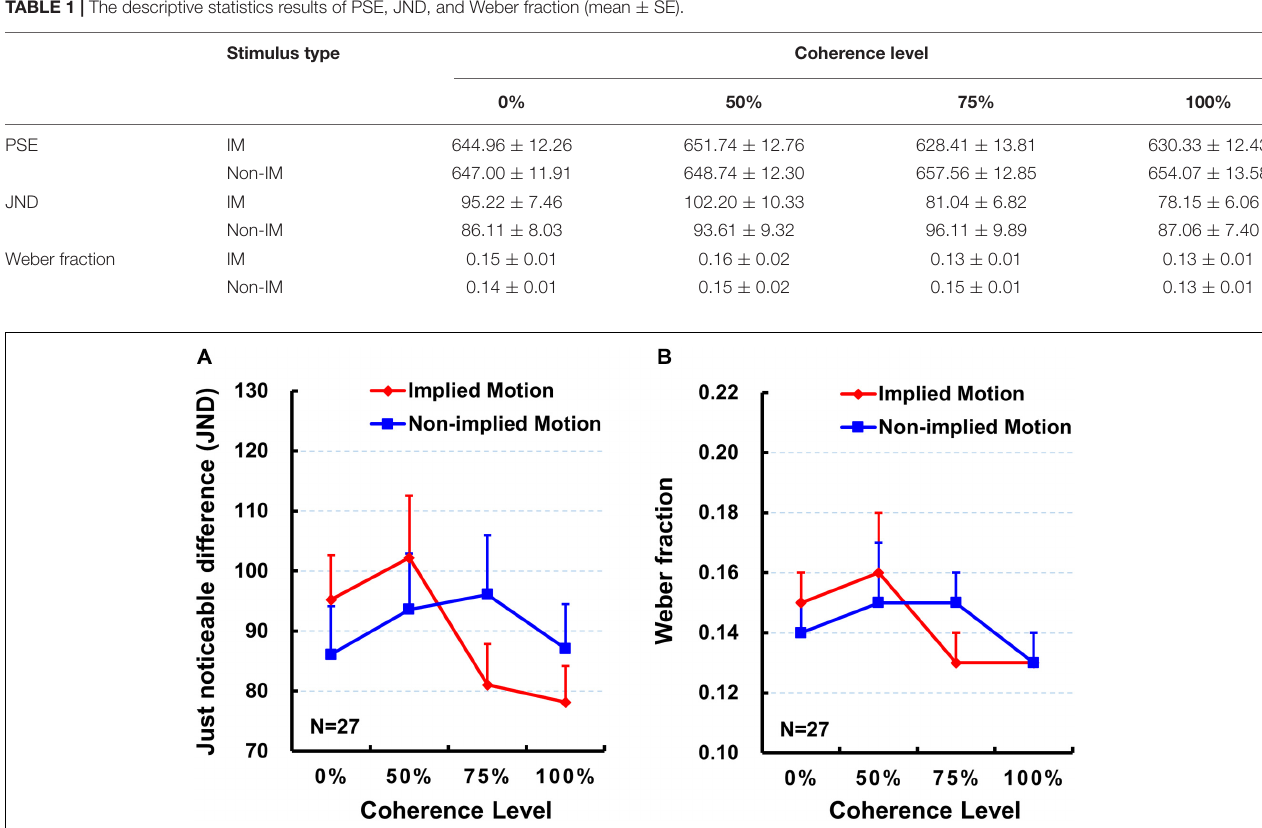
FIGURE 3 | Mean just noticeable difference (JND; A ) and mean Weber fraction (B) for each stimulus type and for each coherence level. Error bars represent standard errors of the mean across subjects. Sample size n = 27.